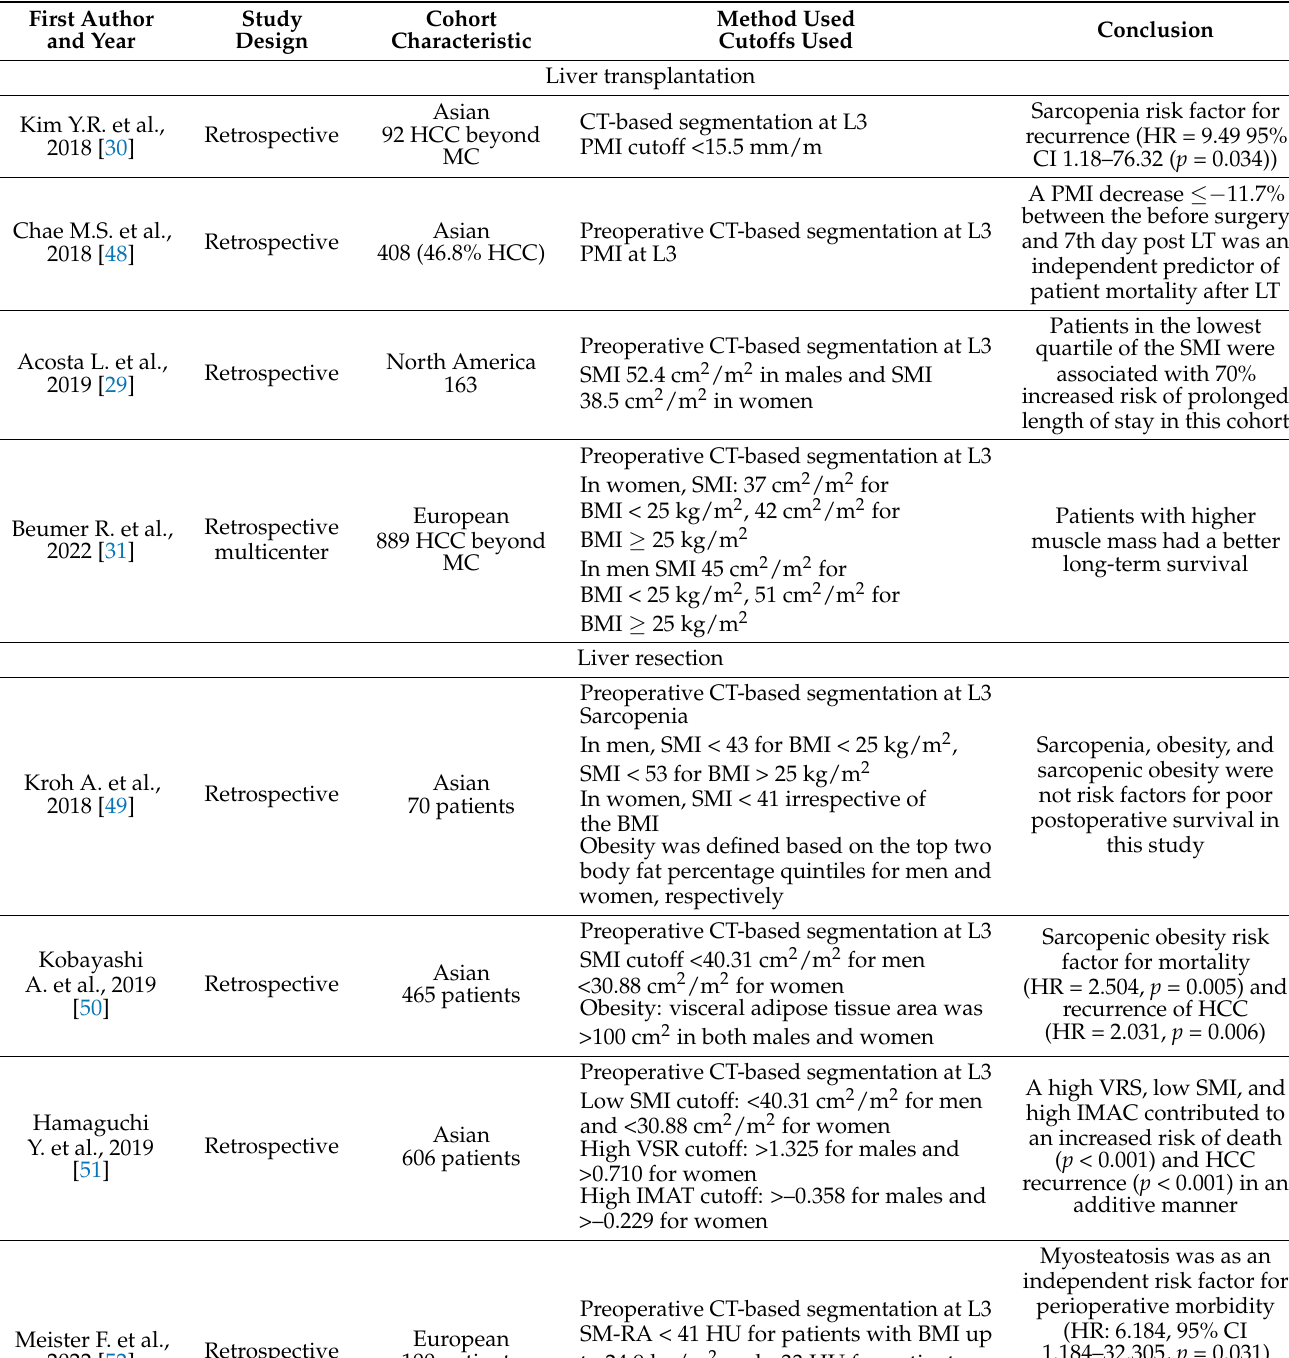
Table 1. Studies evaluating the impact of skeletal musculature changings on HCC patient outcomes assigned to curative therapies published in the last 5